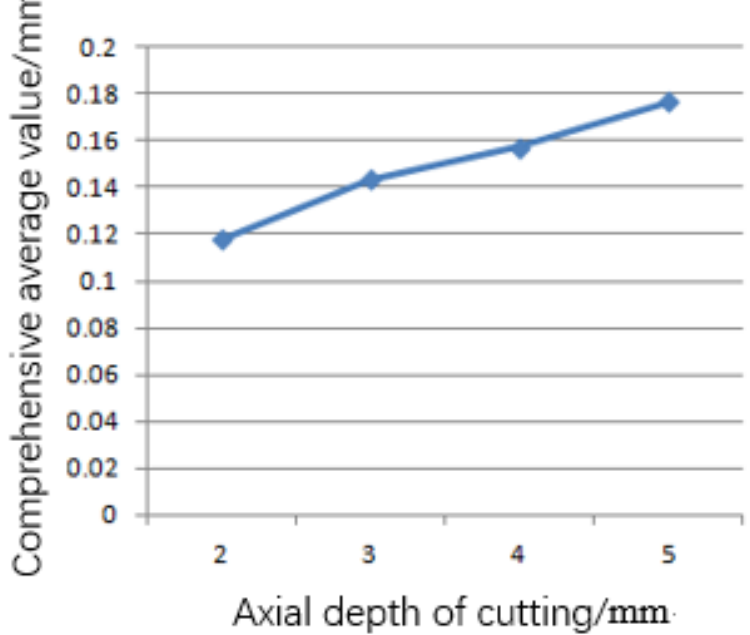
Figure 8. Influence on deformation of different axial cutting depths.